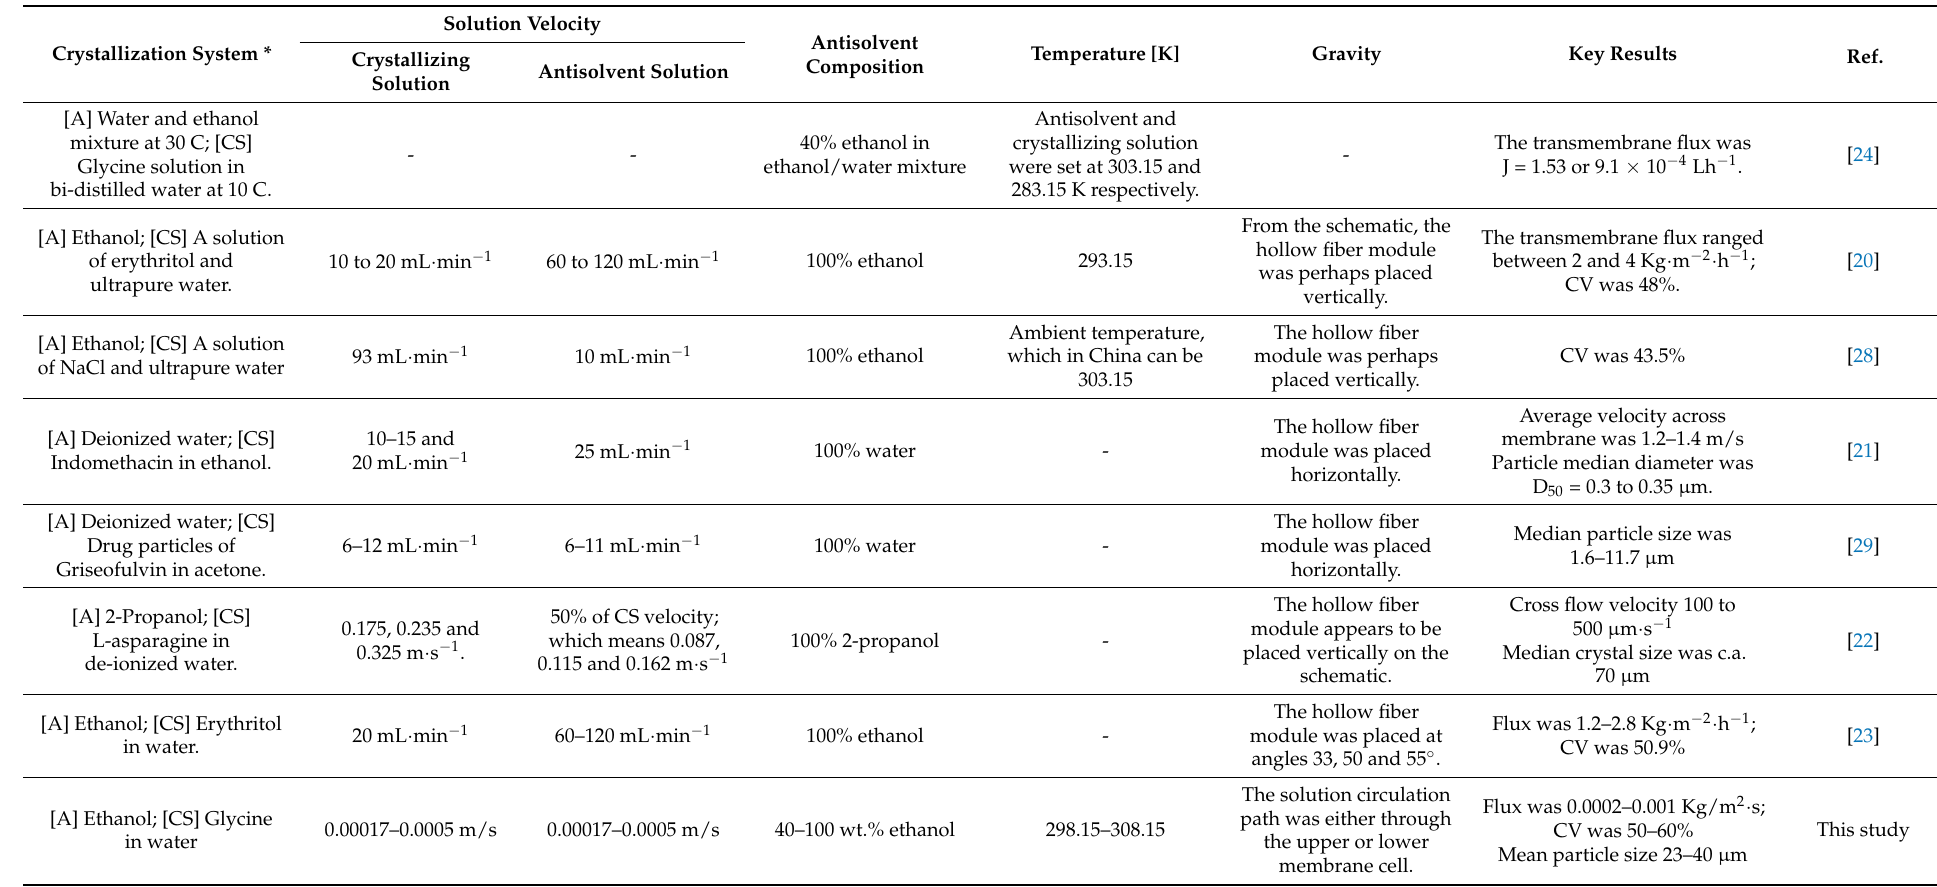
Table 1. Operation conditions that figured in previous MAAC studies, plus the main results regarding antisolvent mass transfer and crystal properties. * [A] Antisolvent; [CS] Crystallizing